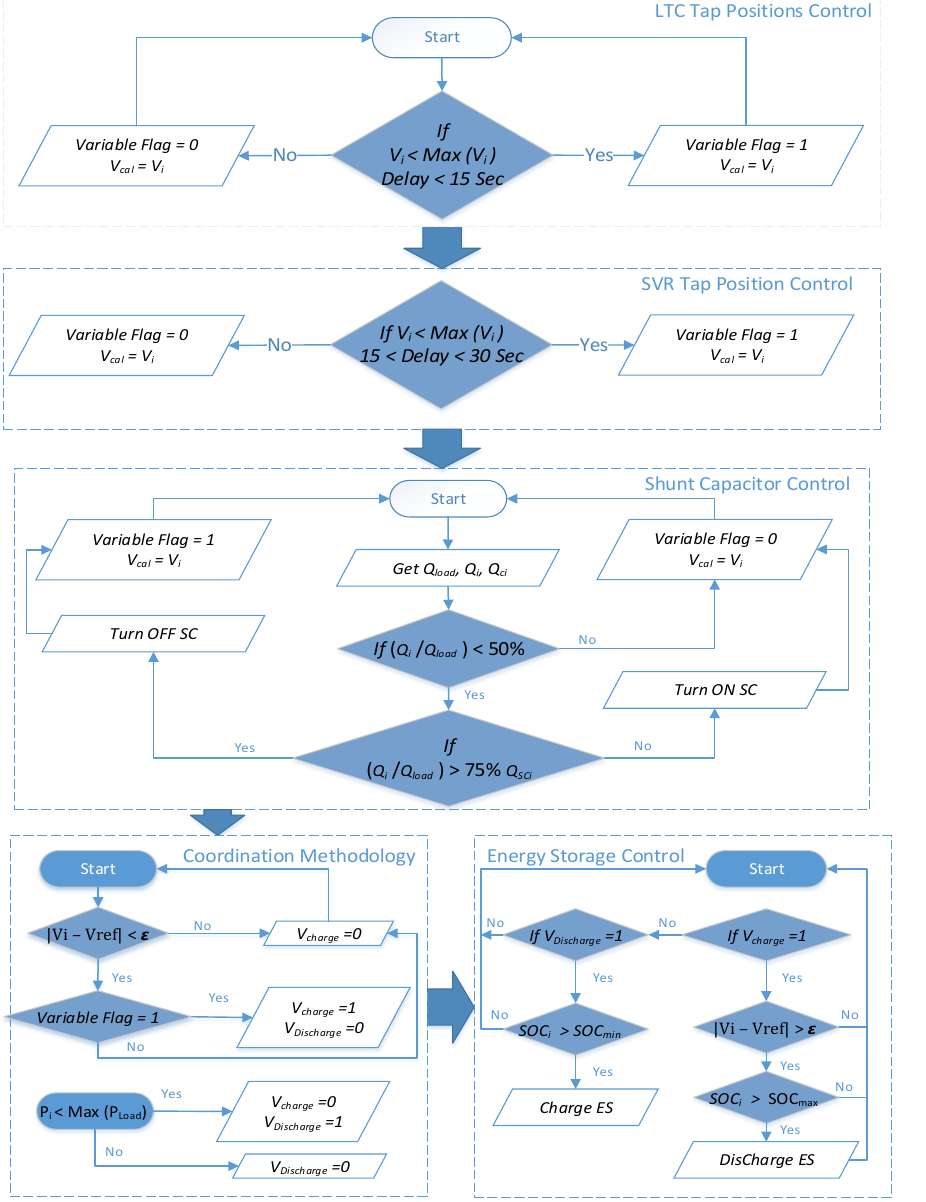
Figure 3. Flowchart for optimal coordination methodology.